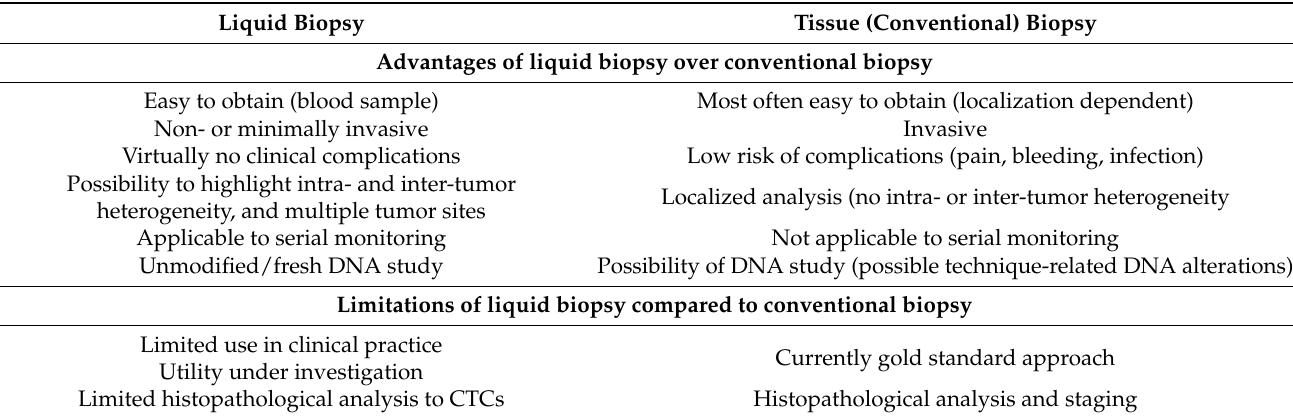
Table 1. Liquid biopsy versus tissue biopsy in skin cancers—advantages and limitations. Liquid